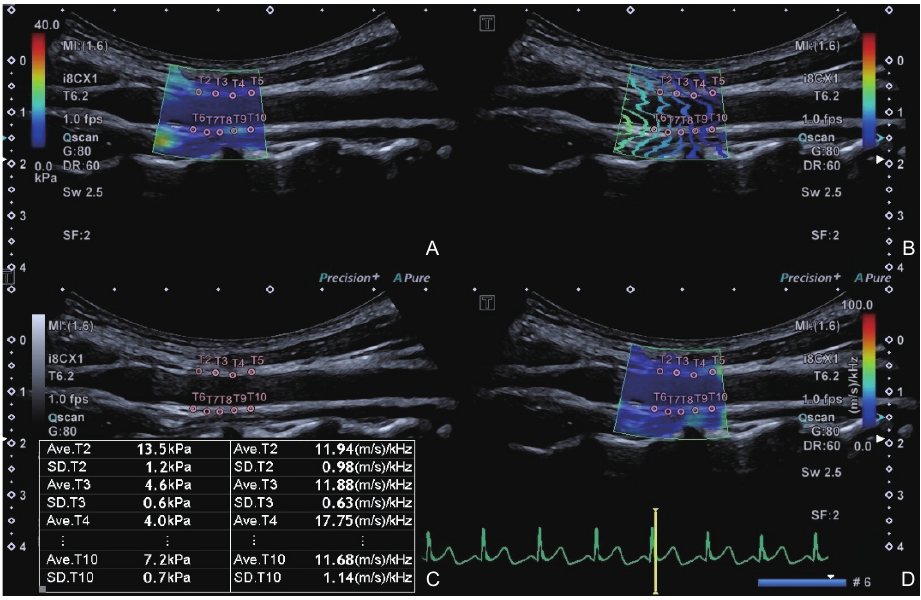
C Figure 1 Quad View of shear wave profile. (A) Elastic map. The shear wave speed is coded on a color scale from blue to red, corresponding to ranging the Young modulus between 0.0 and 40.0kPa. (B) Propagation map. The contour lines represent shear wave arrival times at different points in the tissue. (C) Two-dimensional reference map. (D) Shear wave dispersion map. The shear wave dispersion is also coded on a color scale from blue to red, corresponding to value of dispersion from 0.0 to 100.0 (m/s)/kHz.